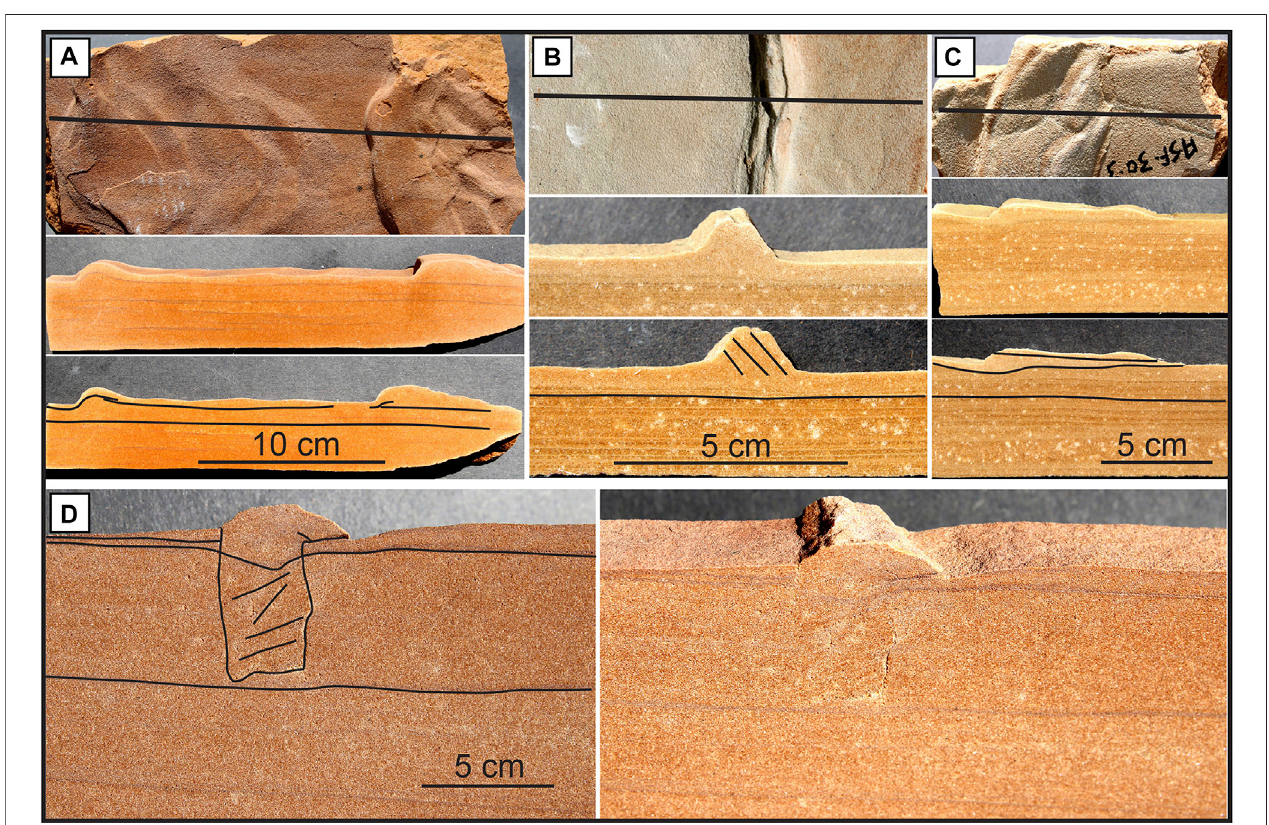
FIGURE4| Cross-sectionalviewsofSSDSsinsandstonesamples.Foreachexample,onephotoisunmarked,and theotherhaslinedrawingstohighlightinternal laminations. (A – D) The upper photos are bedding plane surface views; the black lines indicate the transects along which the cross-sections were cut. (D) A section of sandstone below the ridge appears to have been shifted slightly (visible in left